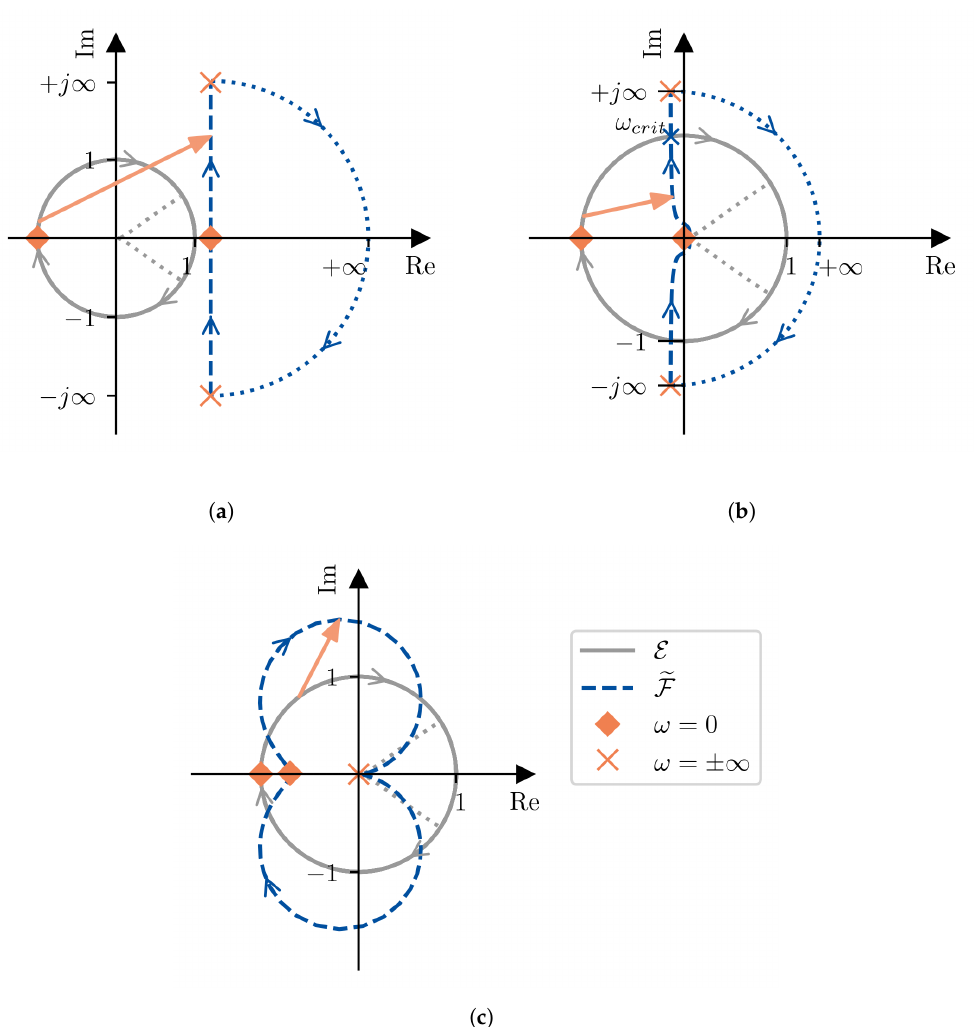
Figure 6. Visualization of the three different cases that need to be considered when analyzing system behavior for systems with dead time. The complex vector between E and (cid:101) F is shown at an arbitrary position. The stability of the system without dead time is assumed. Curves are drawn dotted, where s follows the semicircle of D in the open right half-plane (compare with Figure 5, where the relevant part is drawn dotted as well for reference). Moreover, note that the graphics are intentionally distorted to enable a reasonable visual representation. ( a ) The stability of the system is independent of dead time (Case 1). ( b ) The stability of the system depends on dead time; T d , crit exists (Case 2). ( c ) The system is considered practically unstable as stability depends on the exact position of the complex vector at high frequencies (Case 3). For | s | → ∞ , all values (cid:101) F ( s ) = 0 and, thus, no part of (cid:101) F is drawn dotted as this segment is reduced to a single